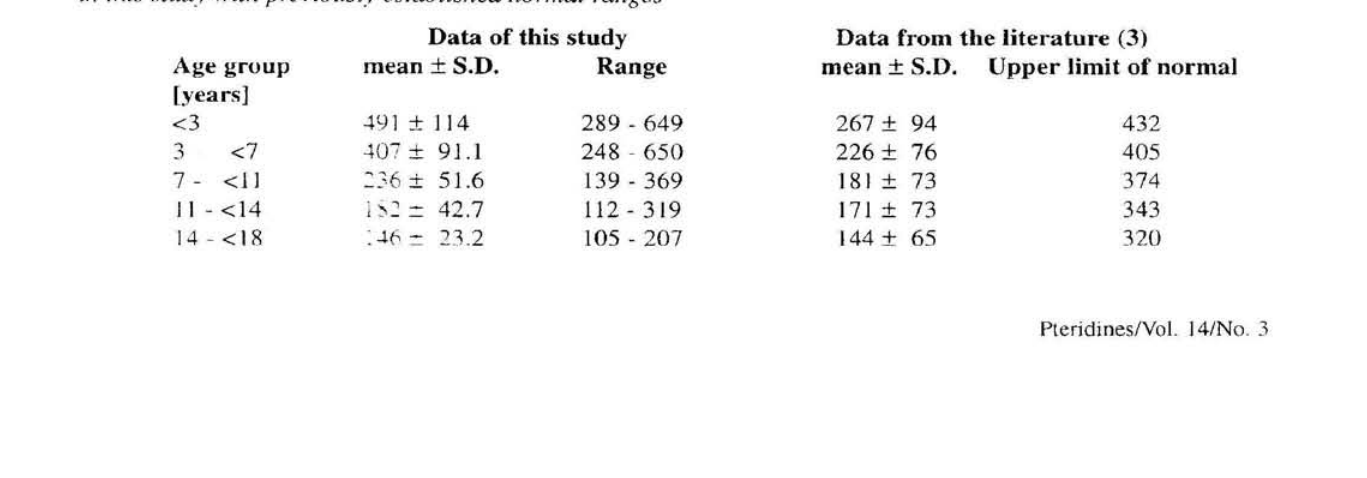
Table I. Comparison of urinary neopterin